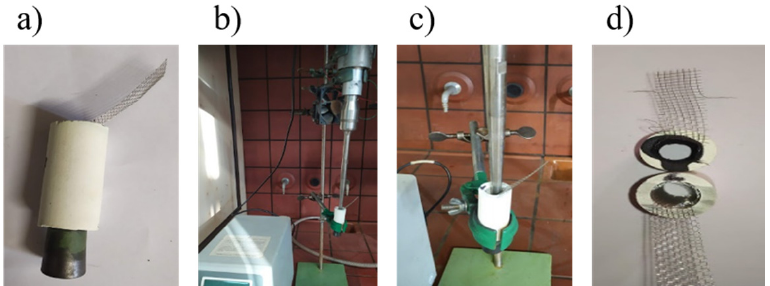
Figure 3. ( a ) Mullite tube with rubber cap, ( b ) and ( c ) setup of ultrasound-assisted deposition, ( d ) tube before and after ultrasound-assisted of HSF54 and AC deposition.